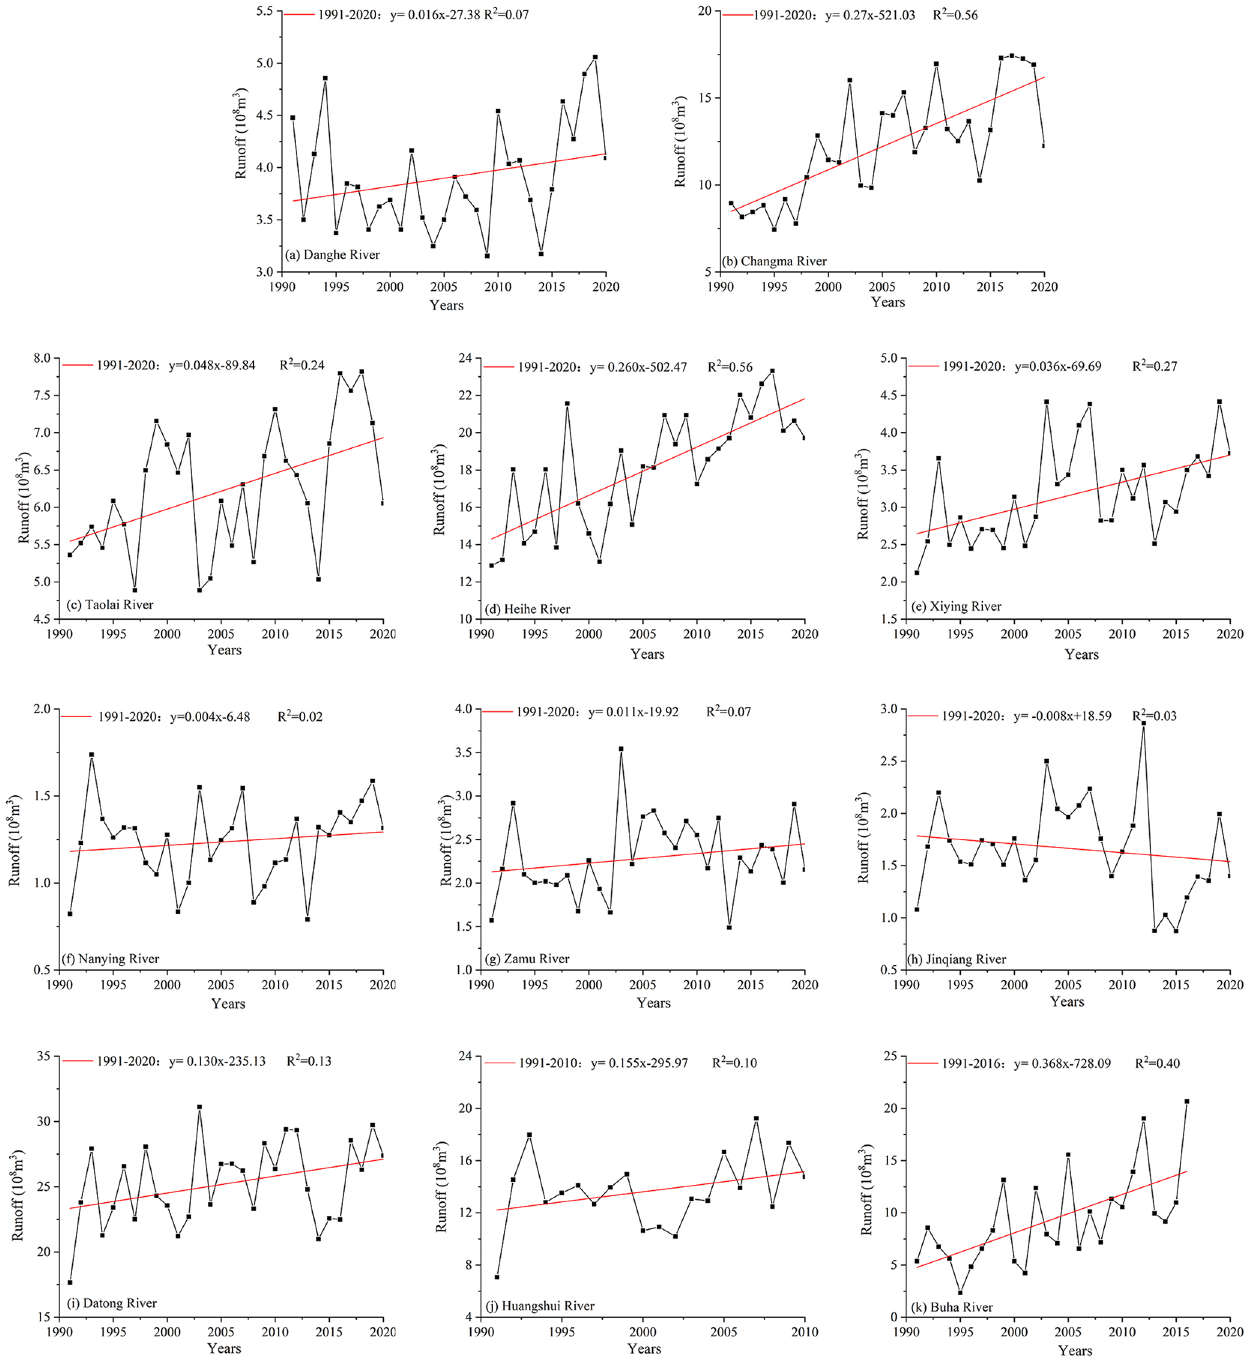
Figure 14. Annual variation of runoff after 1990 in the Qilian